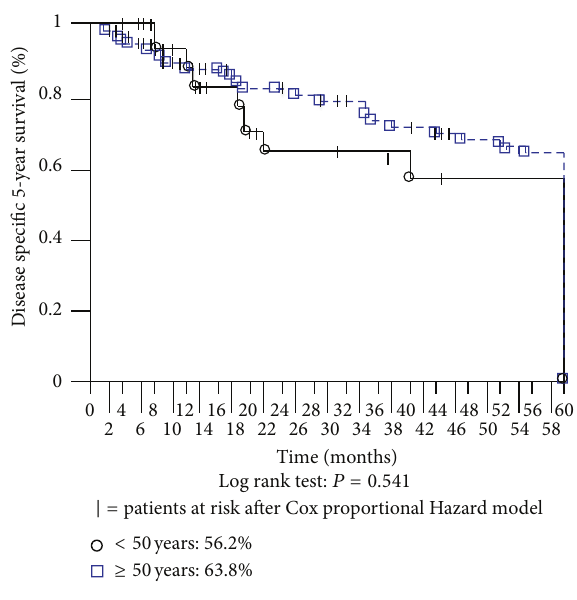
Figure 3: Disease specific 5-year